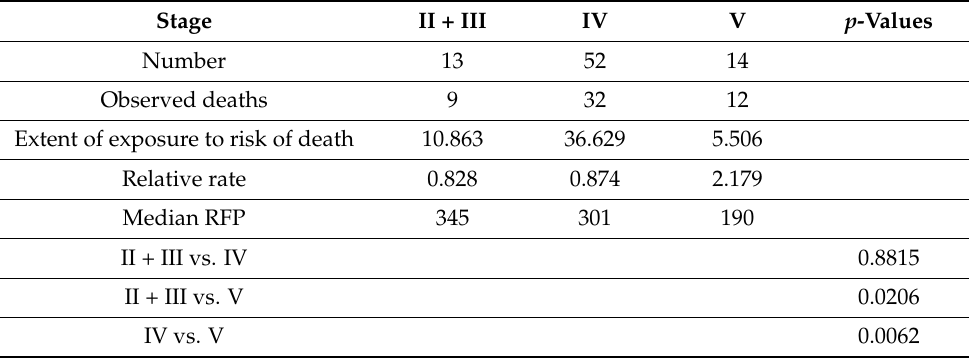
Figure 1. Representation of the overall survival times (OST) of dogs with different stages. Stage II + III (red squares), Stage IV (blue circle), Stage V (green triangle). Table 4. Clinical stages of the patients at the time of diagnosis and their median relapse free periods. The highest median RFP was observed in dogs with Stage II +